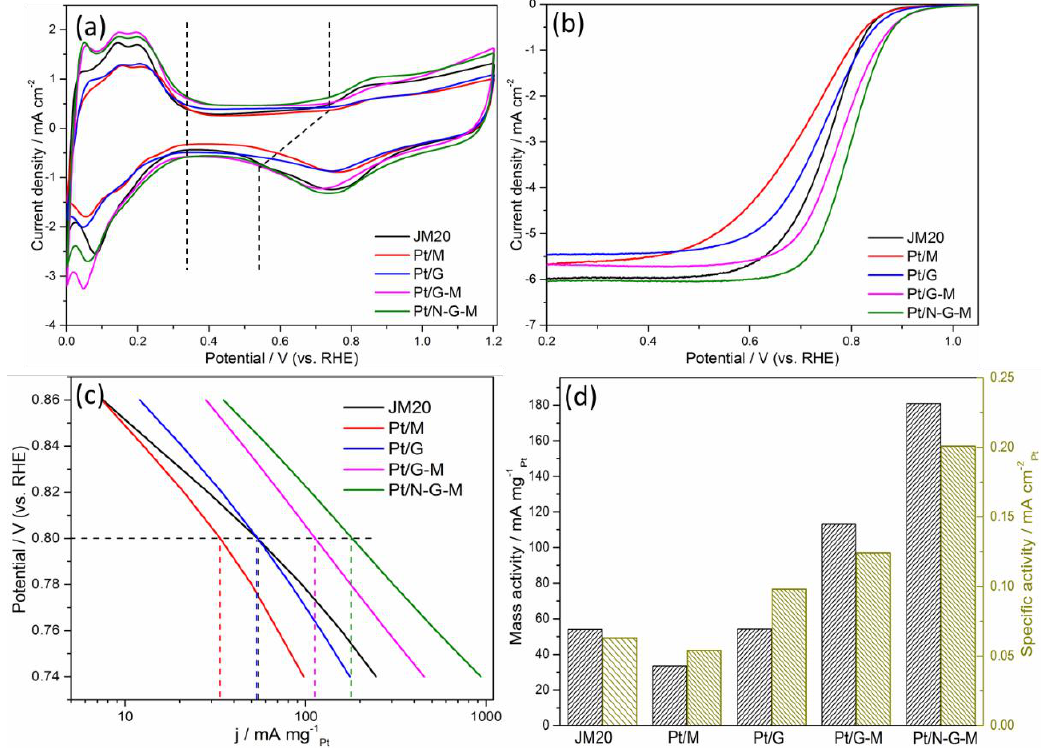
Figure 6. CV curves for ( a ) JM20, Pt/M, Pt/G, Pt/G-M, and Pt/N-G-M in 0.1 M HClO 4 with a potential scan rate of 50 mV·s −1 ; ( b ) LSV curves at 5 mV·s −1 ; ( c ) MA for the ORR of JM20, Pt/M, Pt/G, Pt/G-M, and Pt/N-G-M catalysts; ( d ) MA and SA calculated at 0.80 V.